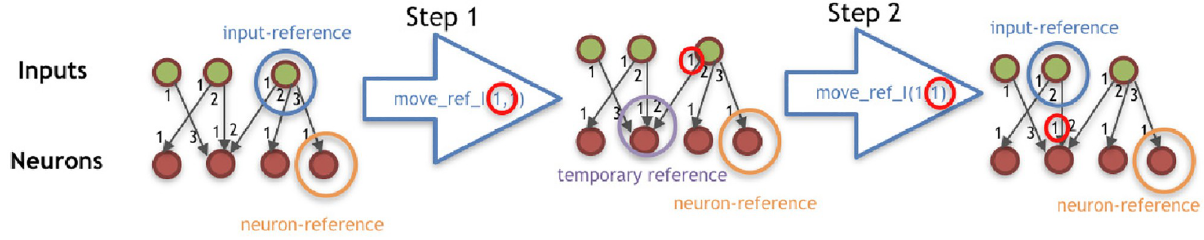
Fig 3. Illustration of command move_ref_I( t i ; d i ), having t i = 1 and d i = 1. The procedure of the command move_ref_N( t n ; d n ) is analogous to this.